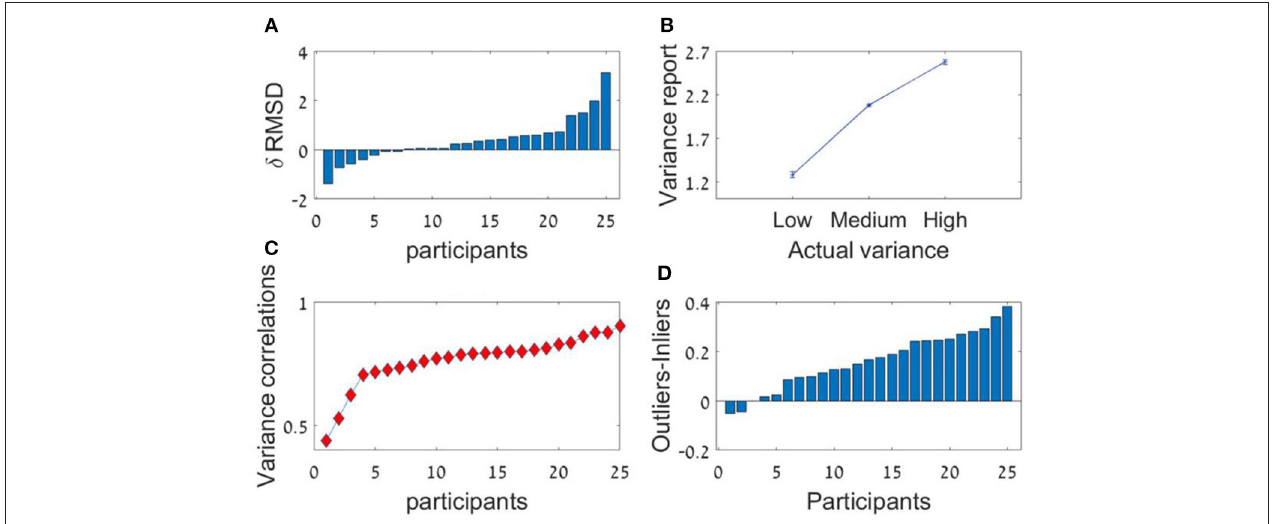
FIGURE 8 | Experiment 2 (A) Individual differences in δ RMSD between the sequence length conditions (positive values indicate improvement in performance as sequence length increases. (B) The average variance reported (y-axis) as a function of the real variance of the sequence (x-axis). (C) Individual difference in the Spearman correlation between variance reported and actual variance for each participant. (D) Individual differences in δ between outliers’ weight (the averaged coefficient of the first and last items in the sequence) and inliers weight (the averaged coefficient of all items between the second and the one before last).